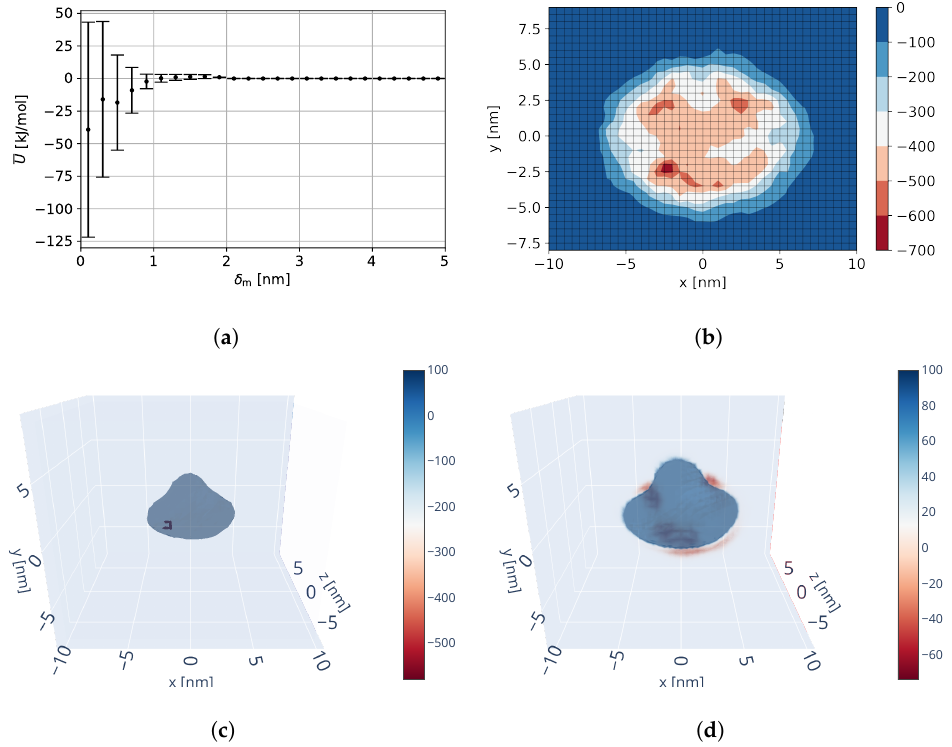
Figure 8. Visualizations of the potential field based on pure MD-based sampling strategy. ( a ) Grid average and standard deviation binned over minimum distance. ( b ) X-Y cross-section minimum over all remaining dimensions. ( c ) 3D minimum over orientations. ( d ) 3D mean over orientations. ( a , b ) adapted from with permission from Ref. [66]. Copyright 2022,